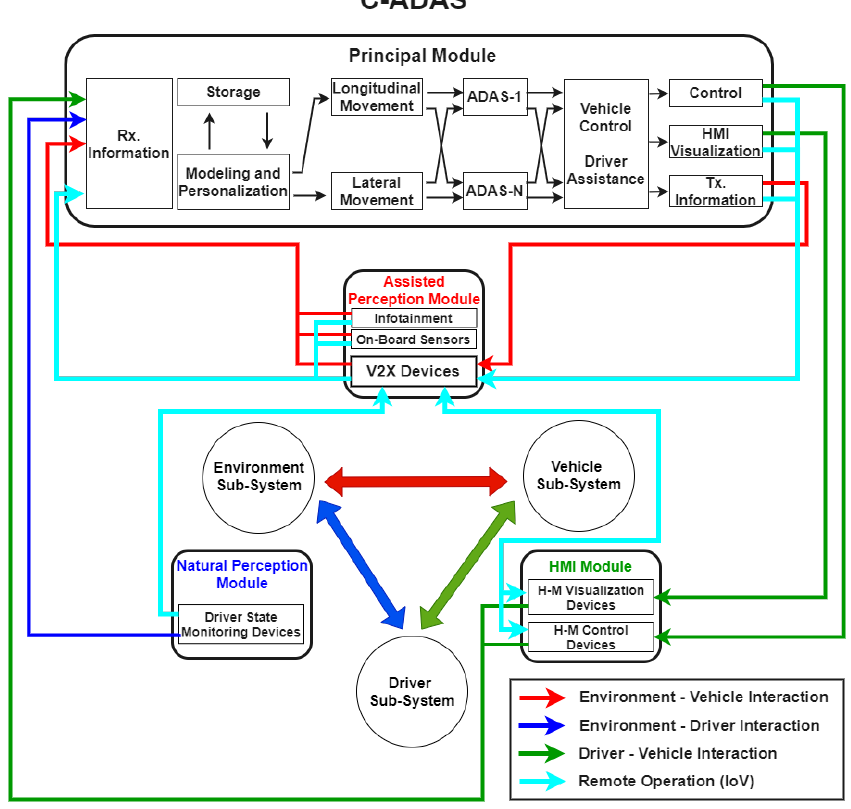
Figure 2. Conceptual architecture of a cooperative advanced driver assistance system (C-ADAS) from the holistic and systemic vision. The red, green, and blue lines indicate the local operation of the principal module (inside the vehicle), while the cyan lines refer to the remote operation of the principal module through the vehicular network under the IoV